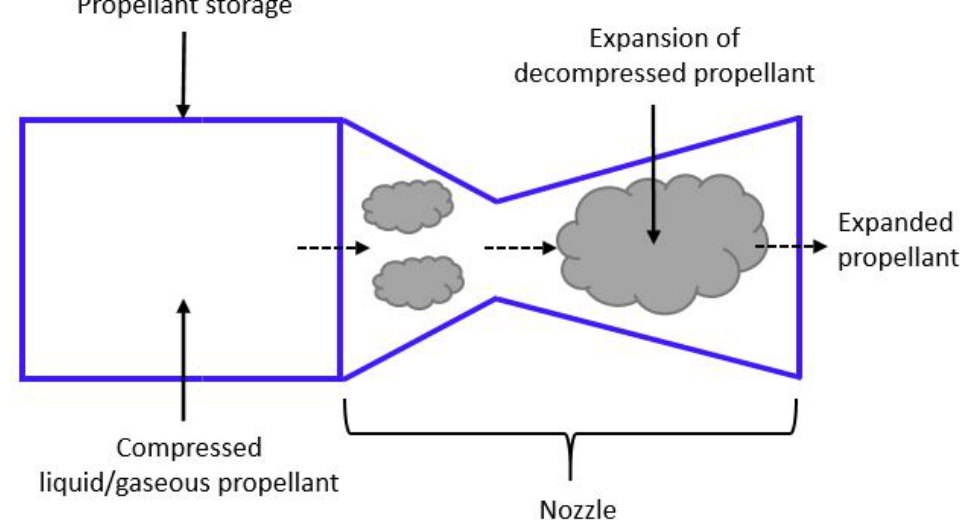
Figure 1. Schematic of a Cold Gas Propulsion